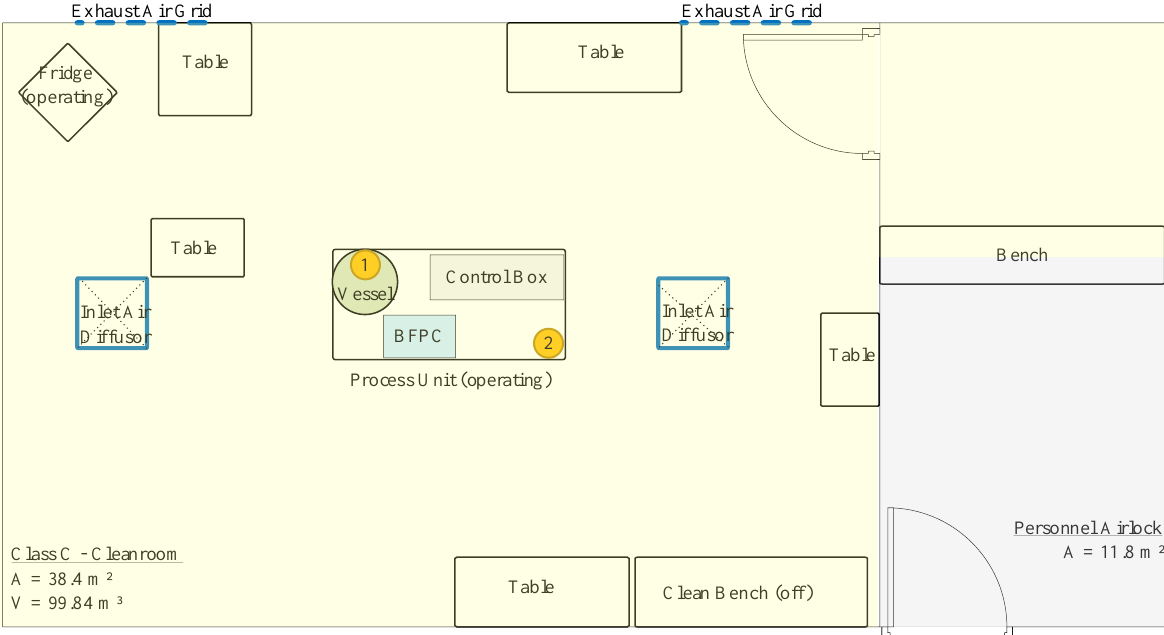
Figure 2. Room layout. For a comparison of the BioTrak ® Biofluorescent Particle Counter (BFPC), (TSI Incorporated, Shoreview, MN, USA) with the classic Microbial Air Sampler (MAS), two different measuring systems were used: Merck Millipore RCS ® (Merck Millipore, Darmstadt, Germany (1)) and ImpactAir ® (Iso-Con Slit-to-Agar, Bridgend, UK (2)). All instruments were placed inside a process unit in the middle of the room.